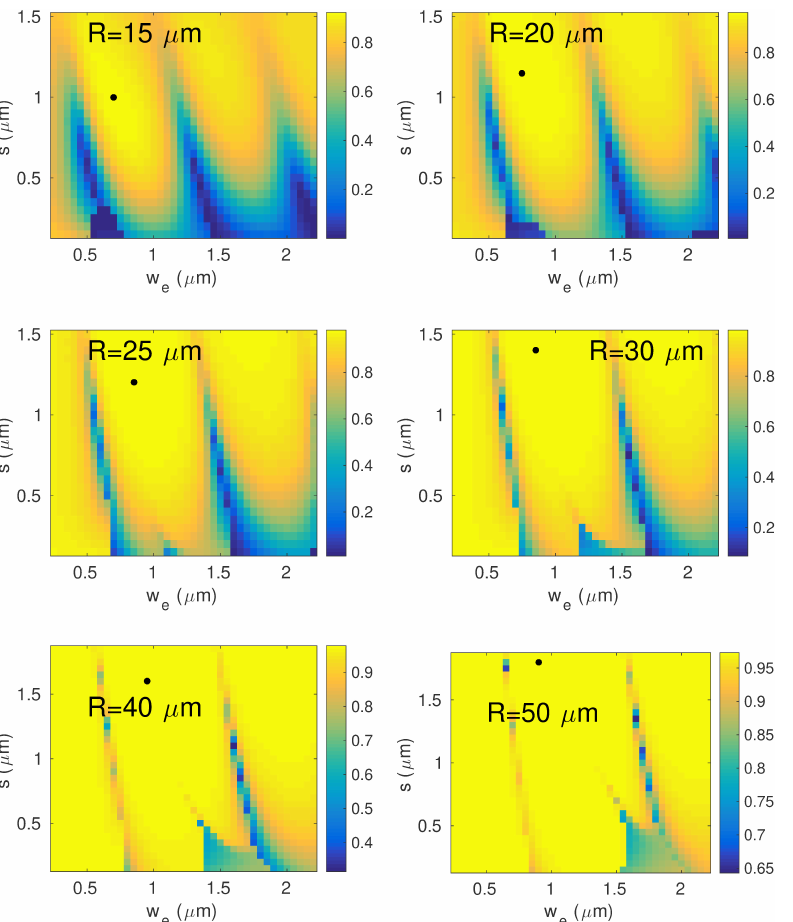
Figure 9. Round-trip field amplitude factor of the principal TE mode for six different values of R : 15 µ m, 20 µ m, 25 µ m, 30 µ m, 40 µ m and 50 µ m at λ = 1550 nm, as a function of the design parameters w e and s . Maximal values of a are indicated with a black dot in the